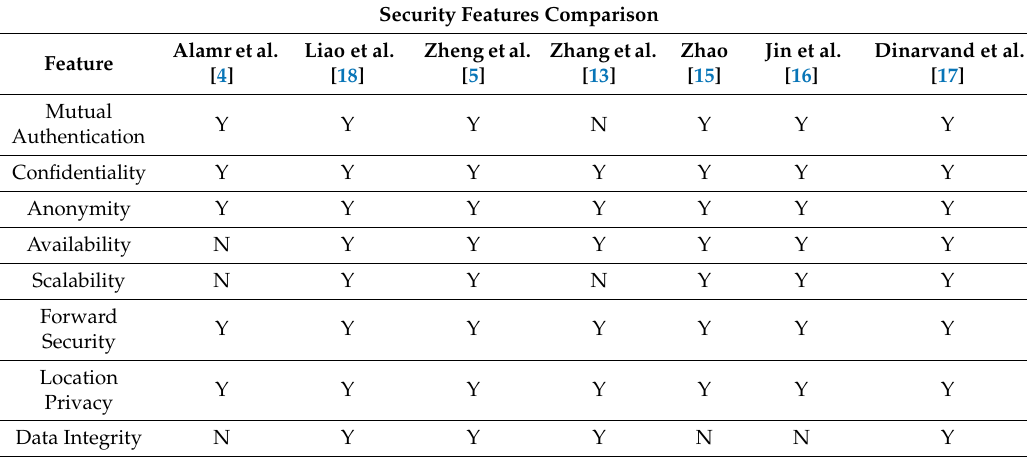
Table 4. Comparison of security features met by the various protocols.